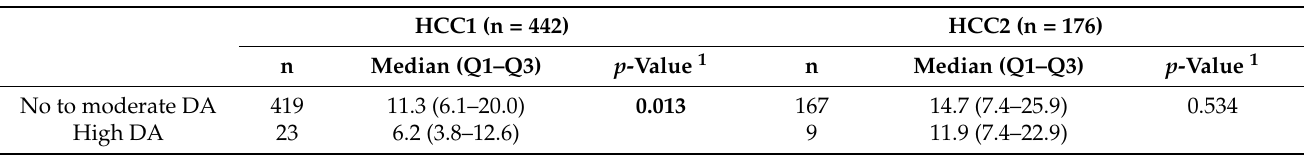
Table 2. Descriptive statistics of hair cortisol concentrations (HCC) within the No to moderate and High dental anxiety (DA) groups at gwk 24 (HCC1) and at delivery